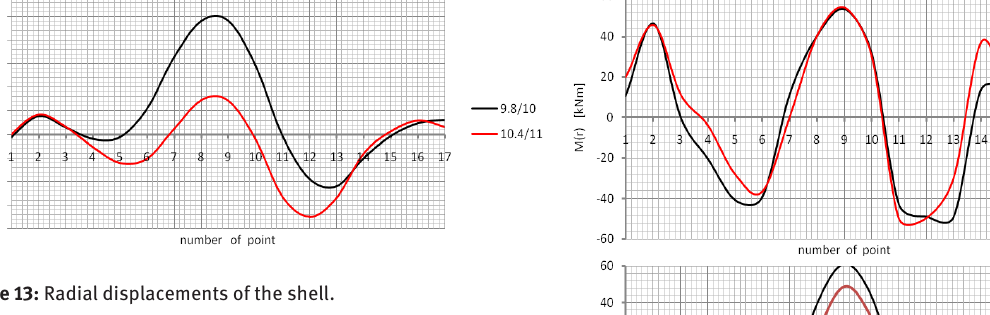
Figure 13: Radial displacements of the shell.